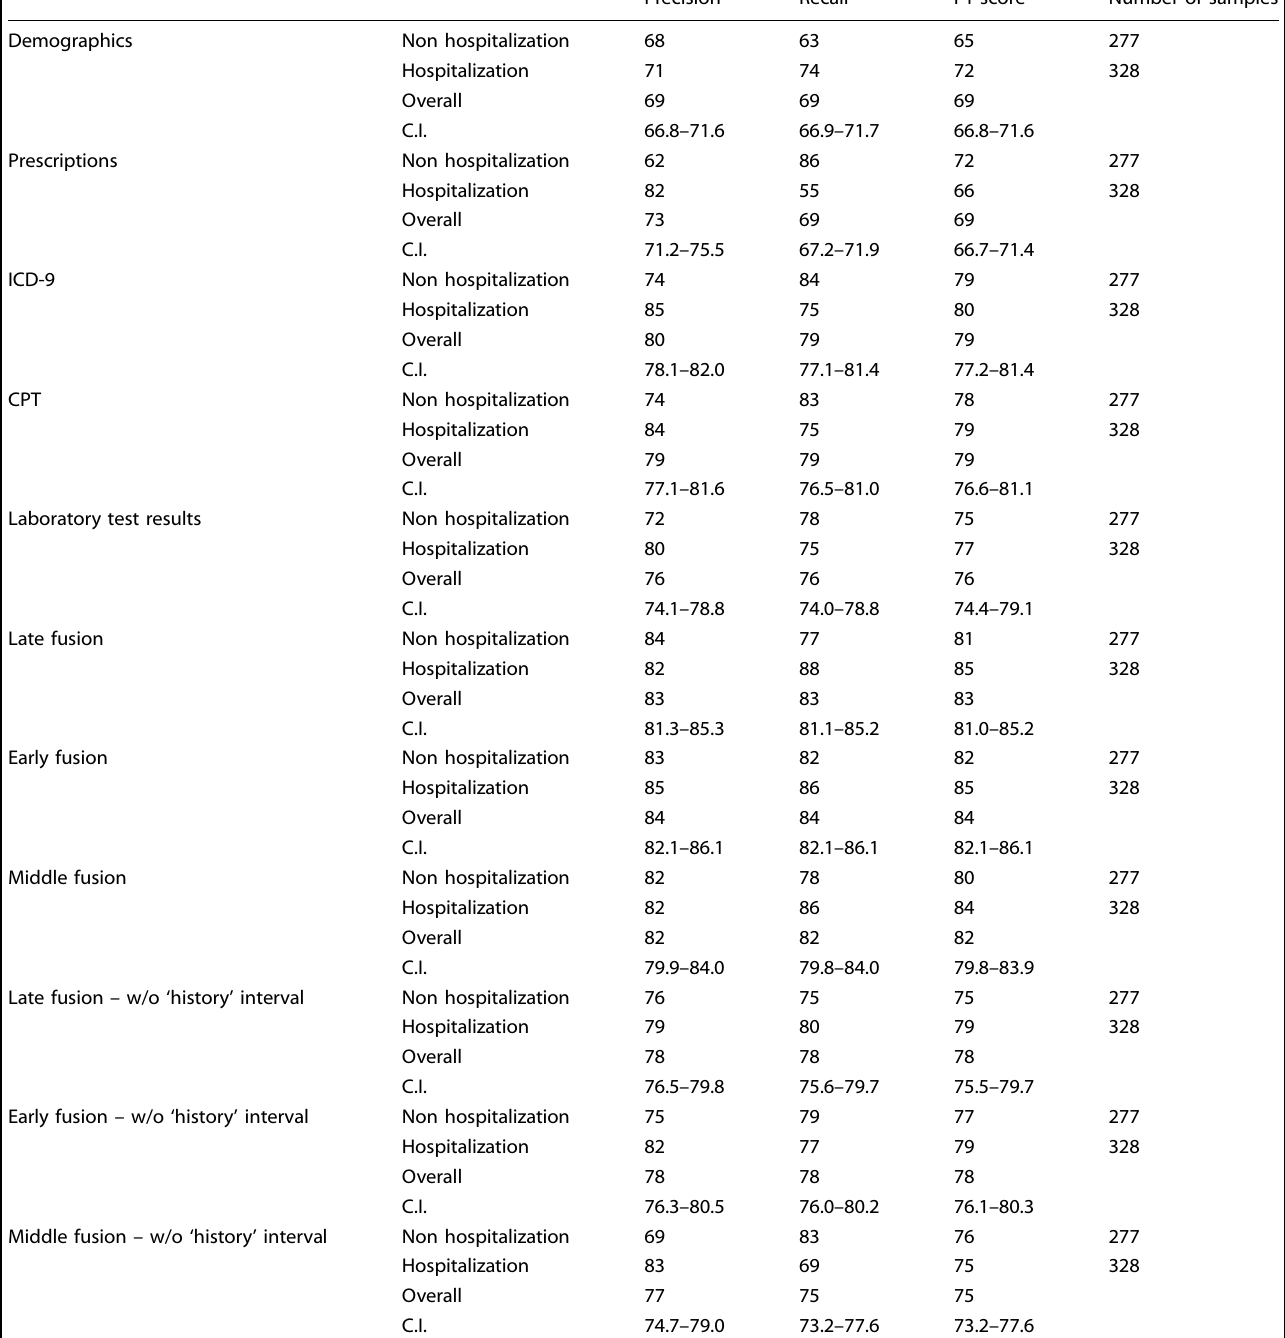
Table 1. Performance for binary classi fi cation models with hospitalization and non-hospitalization as two targets, in terms of class-wise and aggregated (weighted average) precision, recall, and F -score; C.I. (95% con fi dence) was computed using bootstrapping over 1000 iterations with random